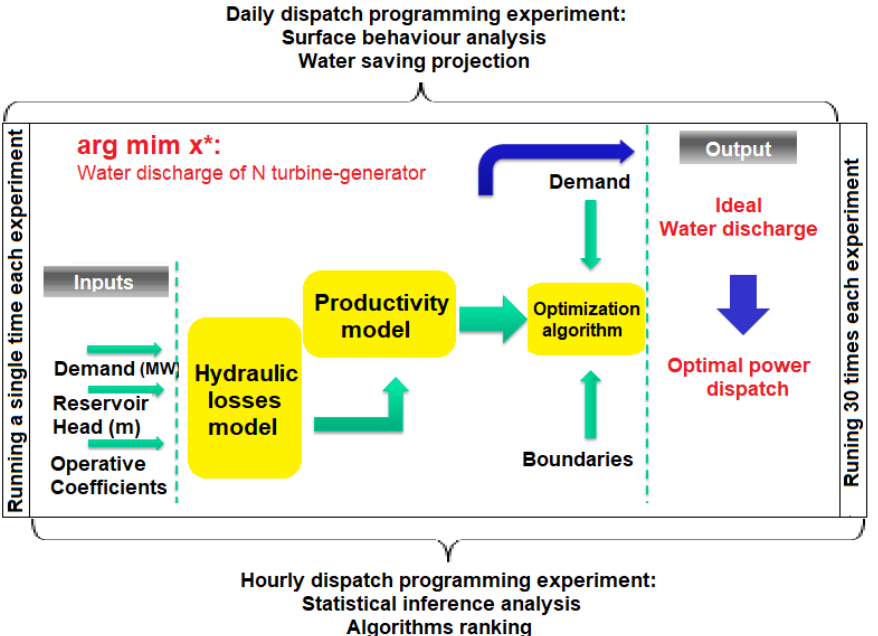
Figure 5. Simulation strategy adopted. The ( upper ) part of the figure exemplifies the Daily dispatch programming experimentation. The ( bottom ) part of the figure exemplifies the Hourly dispatch programming experimentation.